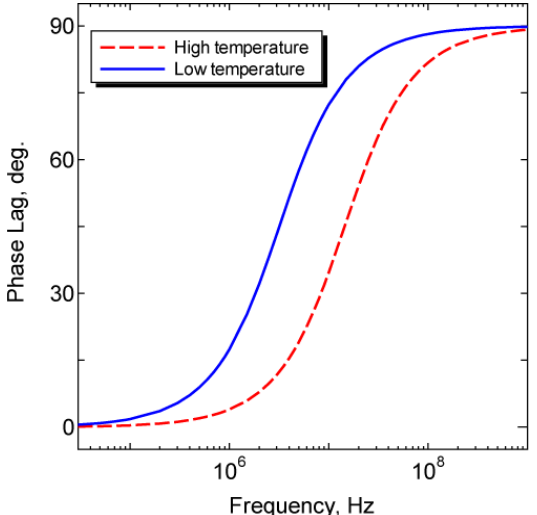
Figure 2. Simulated frequency-phase response in the frequency domain method. The phase lag increases as the modulating frequency increases due to the fluorescence lifetime. The solid and dashed curves show the same fluorophore at different temperatures; the frequency-phase response shifts to a higher frequency as the sample temperature